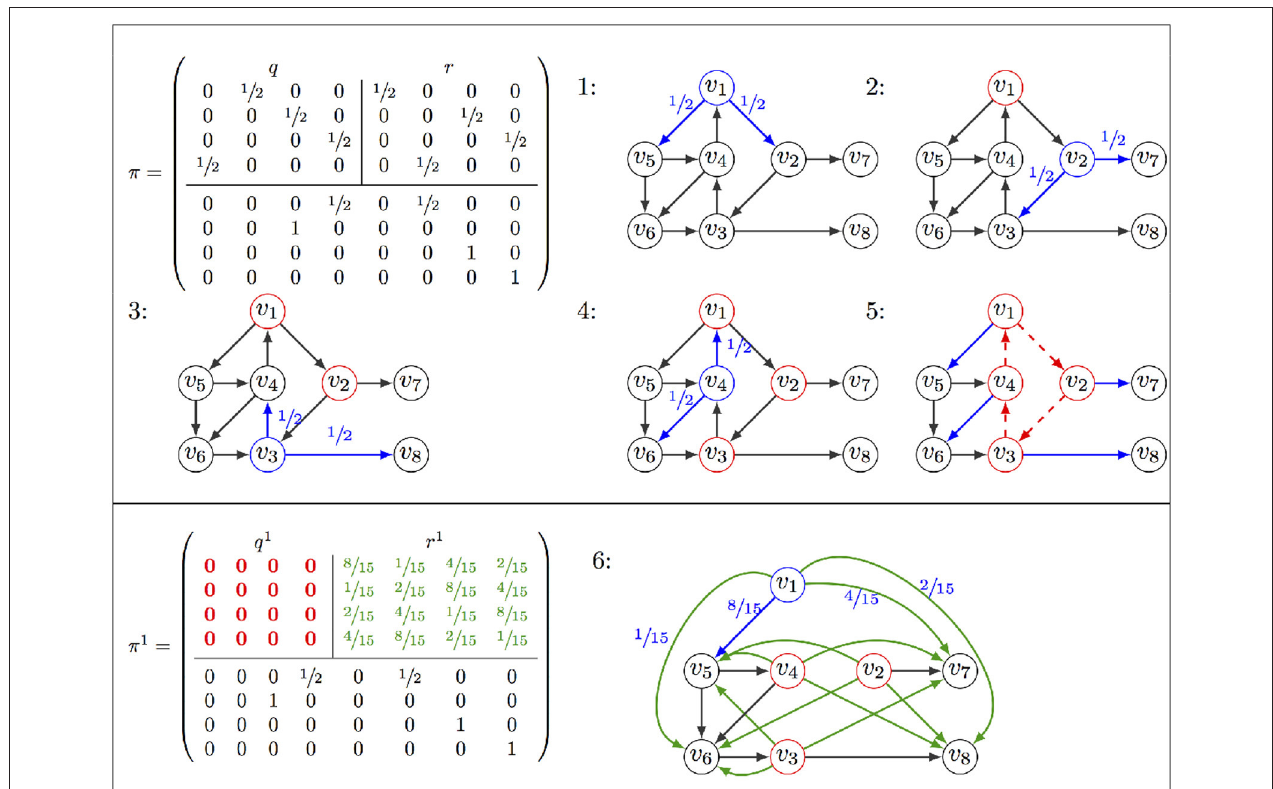
FIGURE 2 | Illustration of AVATAR operation: The transition matrix π is partitioned into the sub-matrices q for transitions between states v 1 , ... v 4 of the cycle to be discovered (Top Left) , and r for transitions leaving the cycle (Top Right) . Exploration starts at v 1 (denoted in blue as well as its leaving transitions with their probabilities), v 2 is selected for the second iteration, and v 1 is indicated as being already visited in red. Exploration proceeds until revisiting v 1 at the 5 th step. Having identified a cycle, the rewiring procedure is launched, removing transitions of the cycle (dotted red) and adding transitions toward exits (green). Probabilities are computed, resulting in a new matrix π 1 , with q 1 ij = 0 and r 1 ij = (( Id − q ) − 1 r ) ij , i = 1, ... 4. From v 1 , an exit of the cycle is chosen according to these probabilities (step